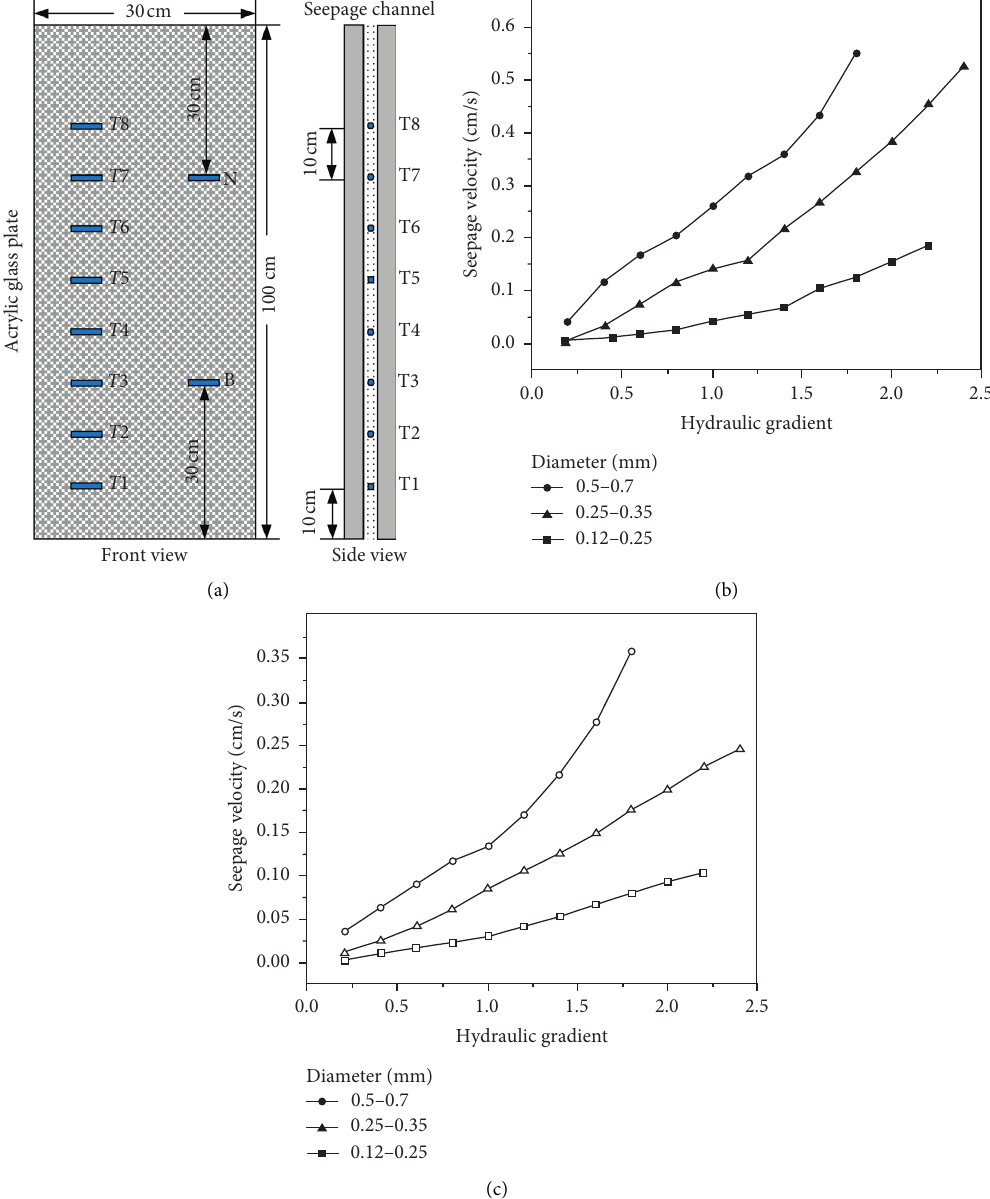
Figure 2: Influence of the seepage channel width and the particle size on the seepage velocity. (a) The seepage testing model using the acrylic glass and the battery carbon rods; (b) crack width: 2 mm; (c) crack width: 5